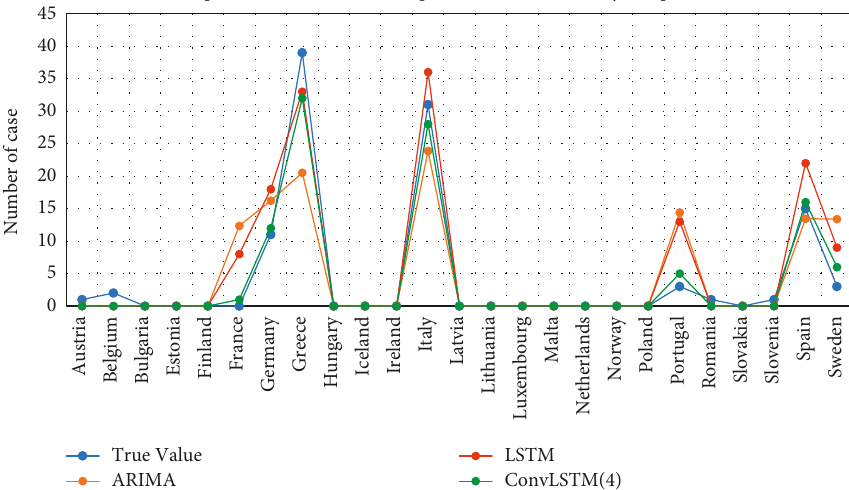
Figure 7: Comparison of different model predictions from January to April 2018.